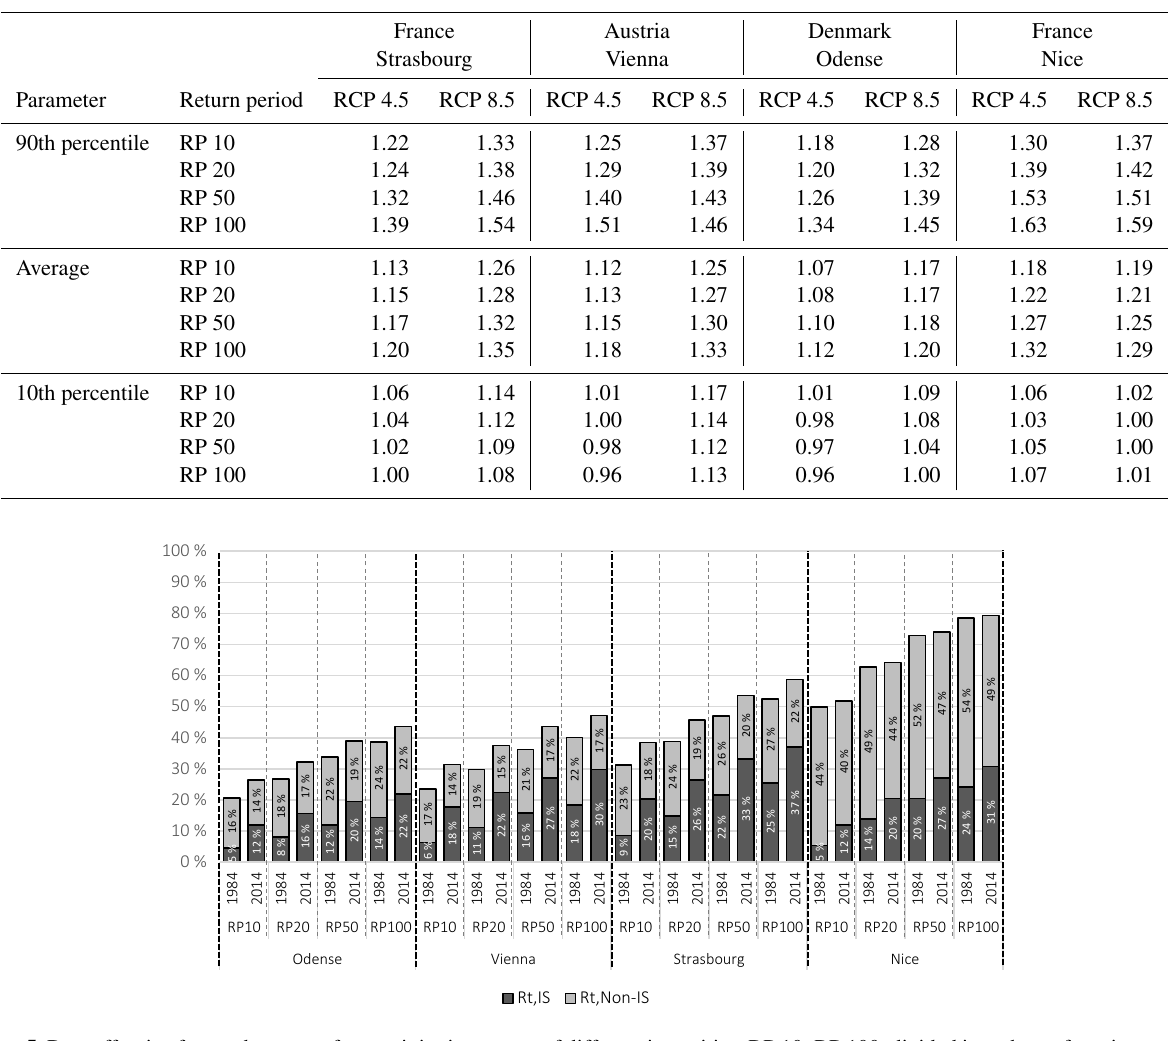
Figure 5. Run-off ratios from urban areas for precipitation events of different intensities, RP 10–RP 100, divided into shares from impervious ( R t, IS ) and pervious surfaces ( R t, non-IS ) . Run-off ratios are shown for historical (1984) and present-day imperviousness (2014 – drainage system as in 1984), and are using present-day precipitation